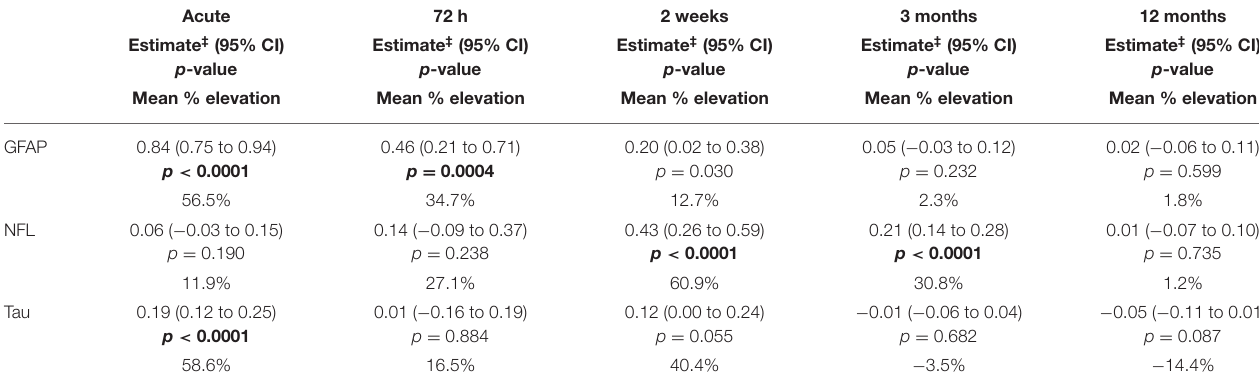
TABLE 2 | Group comparisons of biomarker concentrations between patients with mTBI and controls at each time point, calculated using post-hoc contrast analyses based on the linear mixed model results. Acute 72 h 2 weeks 3 months 12